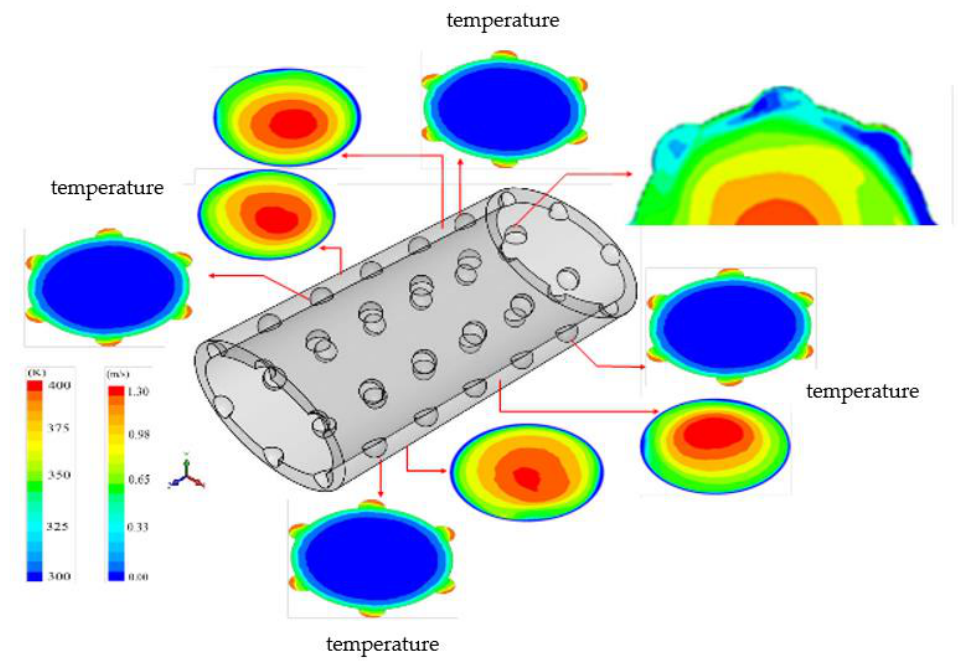
Figure 5. Temperature and velocity contours of hybrid nanofluid flow with VF of 0.4% at Re = 1000 and inlet temperature T in = 323